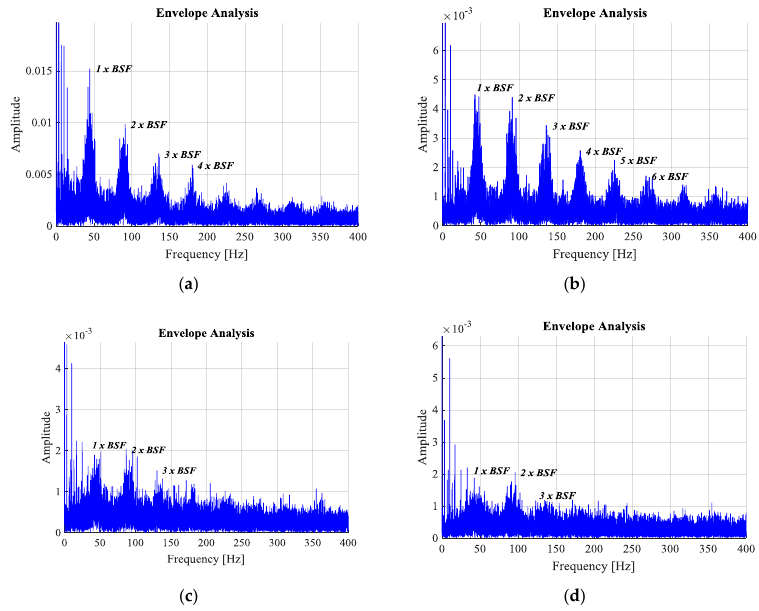
Figure 14. Envelope analysis of recording 15, using bands: ( a ) a band of 0.2–1.8 × 10 3 Hz, ( b ) a band of 1.8–6.1 × 10 3 Hz, ( c ) a band of 6.1–9.2 × 10 3 Hz, ( d ) a band of 9.2–12.8 × 10 3 Hz.